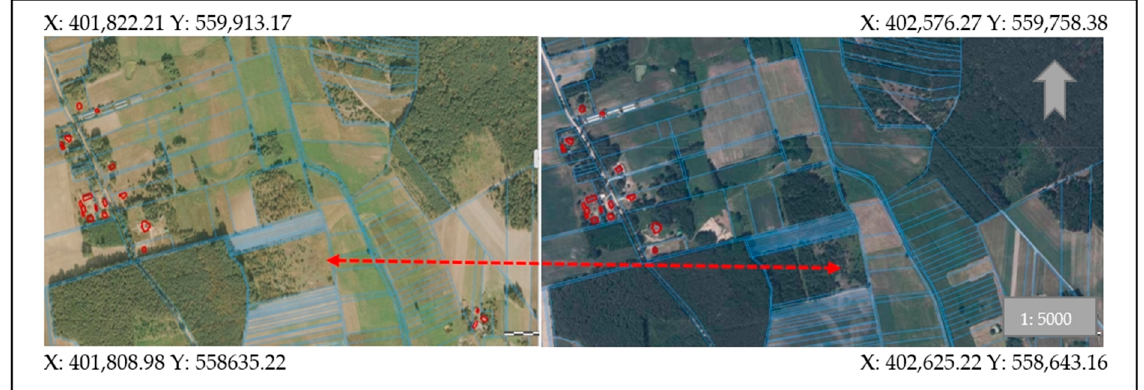
Figure 10. Natural succession resulting from the plot owner’s failure to take relevant actions. Comparison of the state in 2010 ( left ) and in 2020 ( right ). X, Y—coordinates of the corners of the depicted image. Source: own study [40].